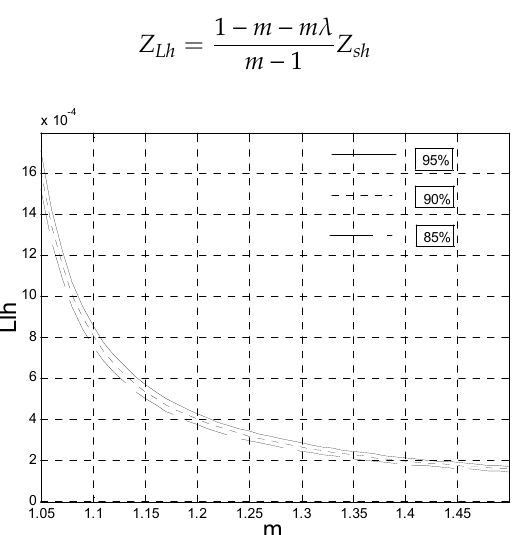
Figure 8. The magnitude of the required series impedance value.